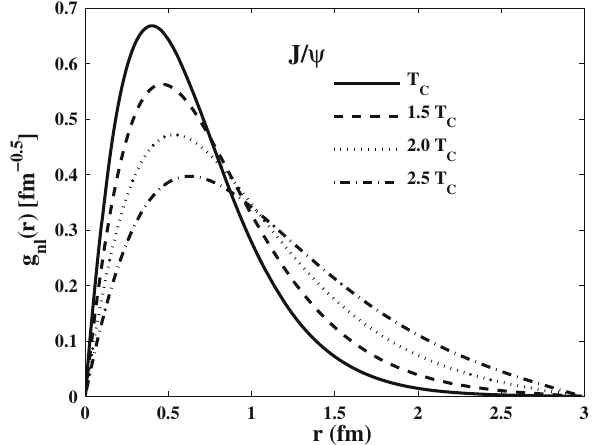
Fig. 6 Variation of radial wavefunction of J /ψ with respect to r at T = T C , 1 . 5 T C , 2 . 0 T C and 2 . 5 T C